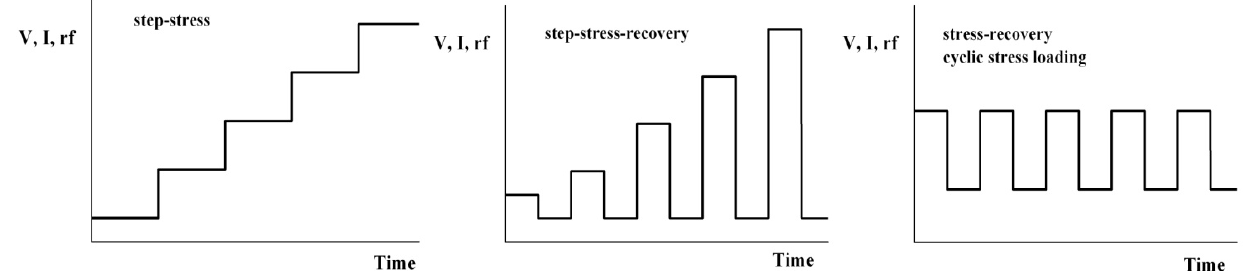
Figure 1. Examples of typical time-dependence of stressing protocols for III-V electronic devices. The parameter that is varied with time can be voltage, current, RF power, amongst others.